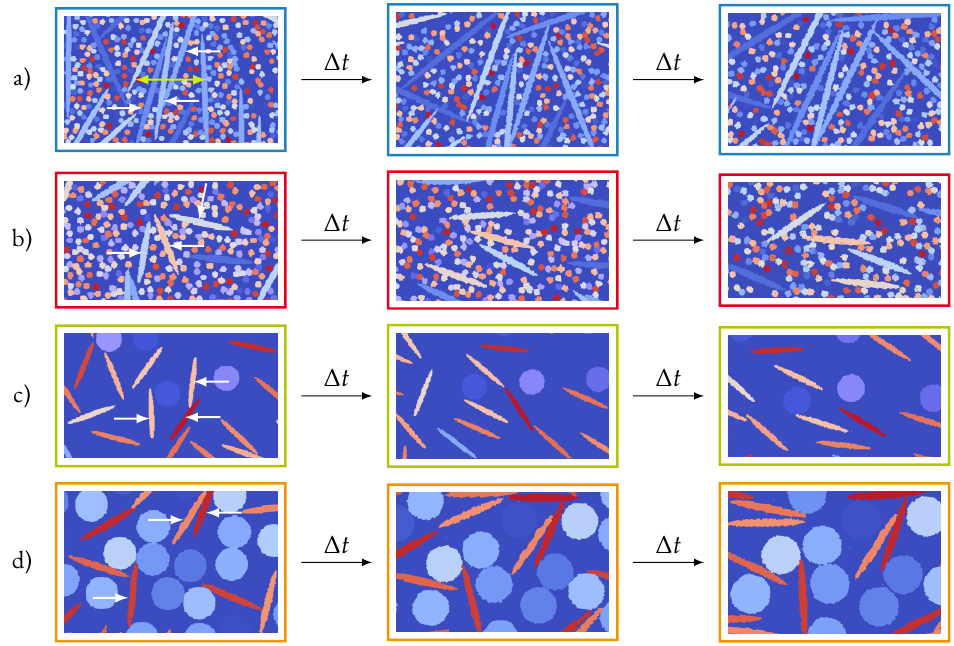
Figure 13. Cutouts of selected snapshots from the simulations marked by colored points in Figures 9 and 12. The yellow double-ended arrow points into the direction of steady-state orientation for the